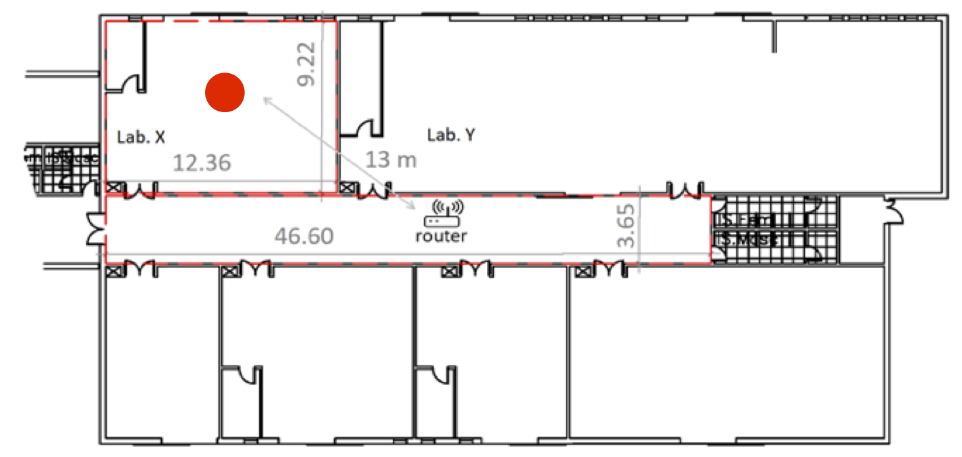
Figure 7. Installation mapping of the tests conducted.